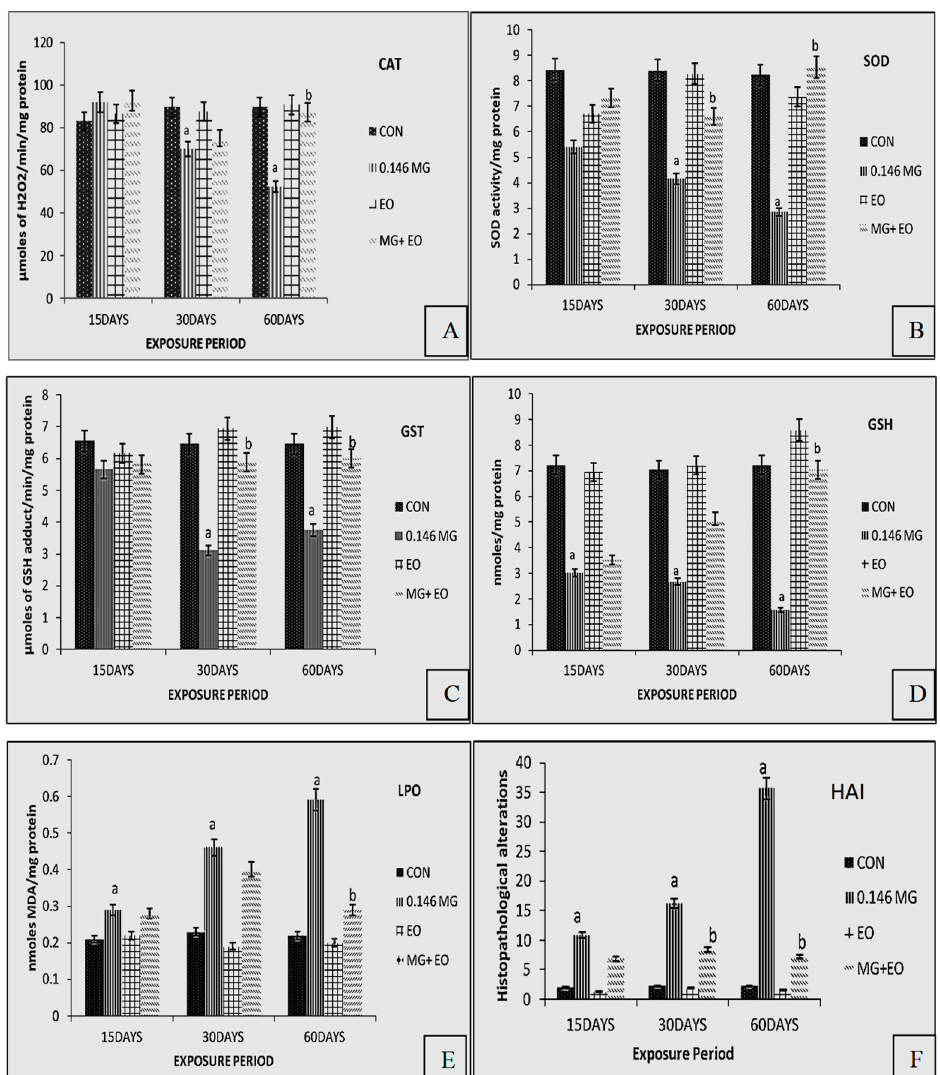
Figure 5. Variation in the anti-oxidant enzyme activity and histopathological index (HAI) in liver of C. carpio exposed to malachite green and E. officinalis for 15, 30 and 60 days. ( A )—Catalase; ( B )—Superoxide dismutase; ( C )—Glutathione-S-Transferase; ( D )—Reduced Glutathione; ( E )—Lipid peroxidation; ( F )—Histopathological Alteration Index. Abbreviations: CON: control; 0.146 MG: 0.146 mg/L MG; EO: Emblica officinalis ; MG + EO: 0.146 mg/L MG + E. officinalis . “a” indicates significant ( p < 0.05) change with respect to control in MG treated fish, and “b” indicates